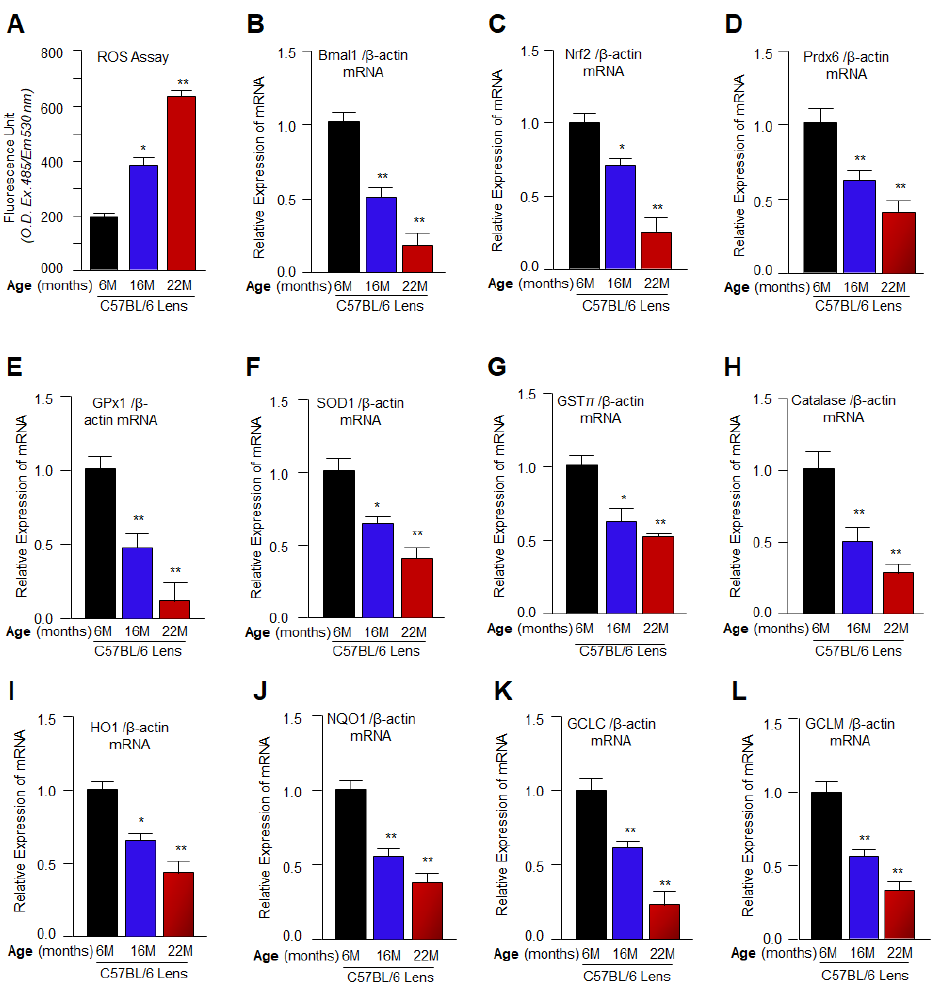
Figure 1. C57BL/6 mouse lenses showed progressive increase of ROS accumulation with a significant decline in Bmal1, Nrf2 and its target antioxidant genes expression during aging. ( A ) Intracellular ROS of lenses of different ages were quantified using H2-DCF-DA dye as described in Materials and Methods and as indicated in figure. Data represents the mean ± S.D. from three independent experiments. Young [6 months (M)] vs. aging (16 M and 22 M) samples. * p < 0.05; ** p < 0.001. ( B – L ) Total RNA was extracted from lenses of different ages and transcribed cDNA was submitted to real-time PCR analysis with specific primers corresponding molecules as indicated. Data represents the mean ± S.D. from three independent experiments. Young (6 M) vs. aging (16 M and 22 M) samples. * p < 0.05; ** p <